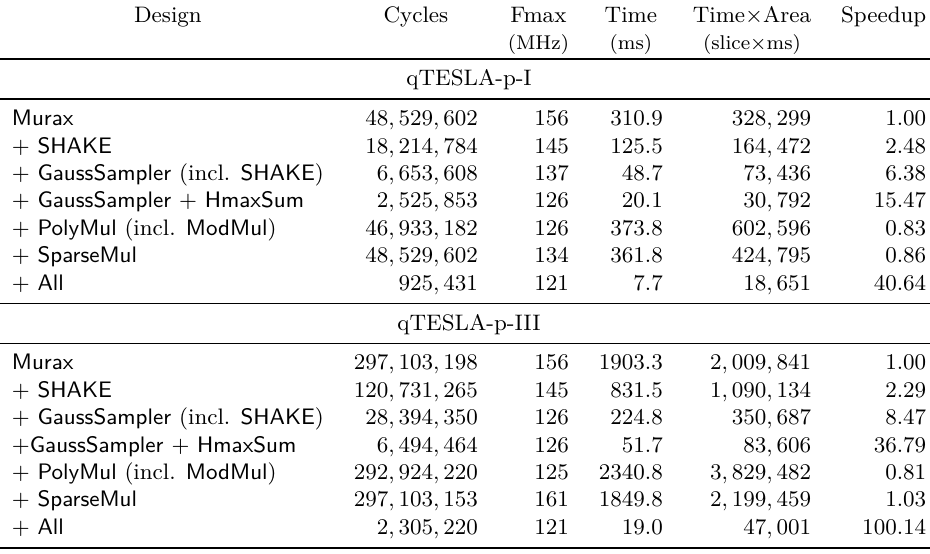
Table 9: Performance of qTESLA key generation on software and different HW-SW co-designs. All = GaussSampler + HmaxSum + PolyMul + SparseMul . The “Speedup” column is provided in terms of time.